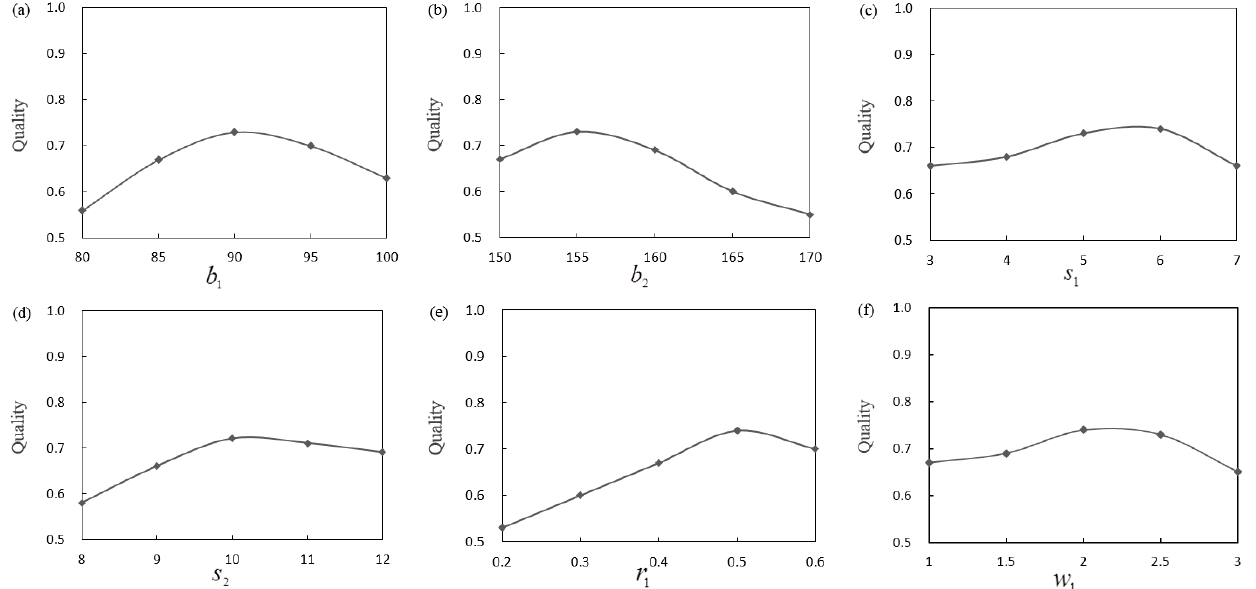
Figure 12. Sensitivity test of free parameters. ( a ) the brightness threshold brightness threshold b ; ( c ) the standard deviation threshold 2 s ; ( e ) the rectangularity threshold threshold 2